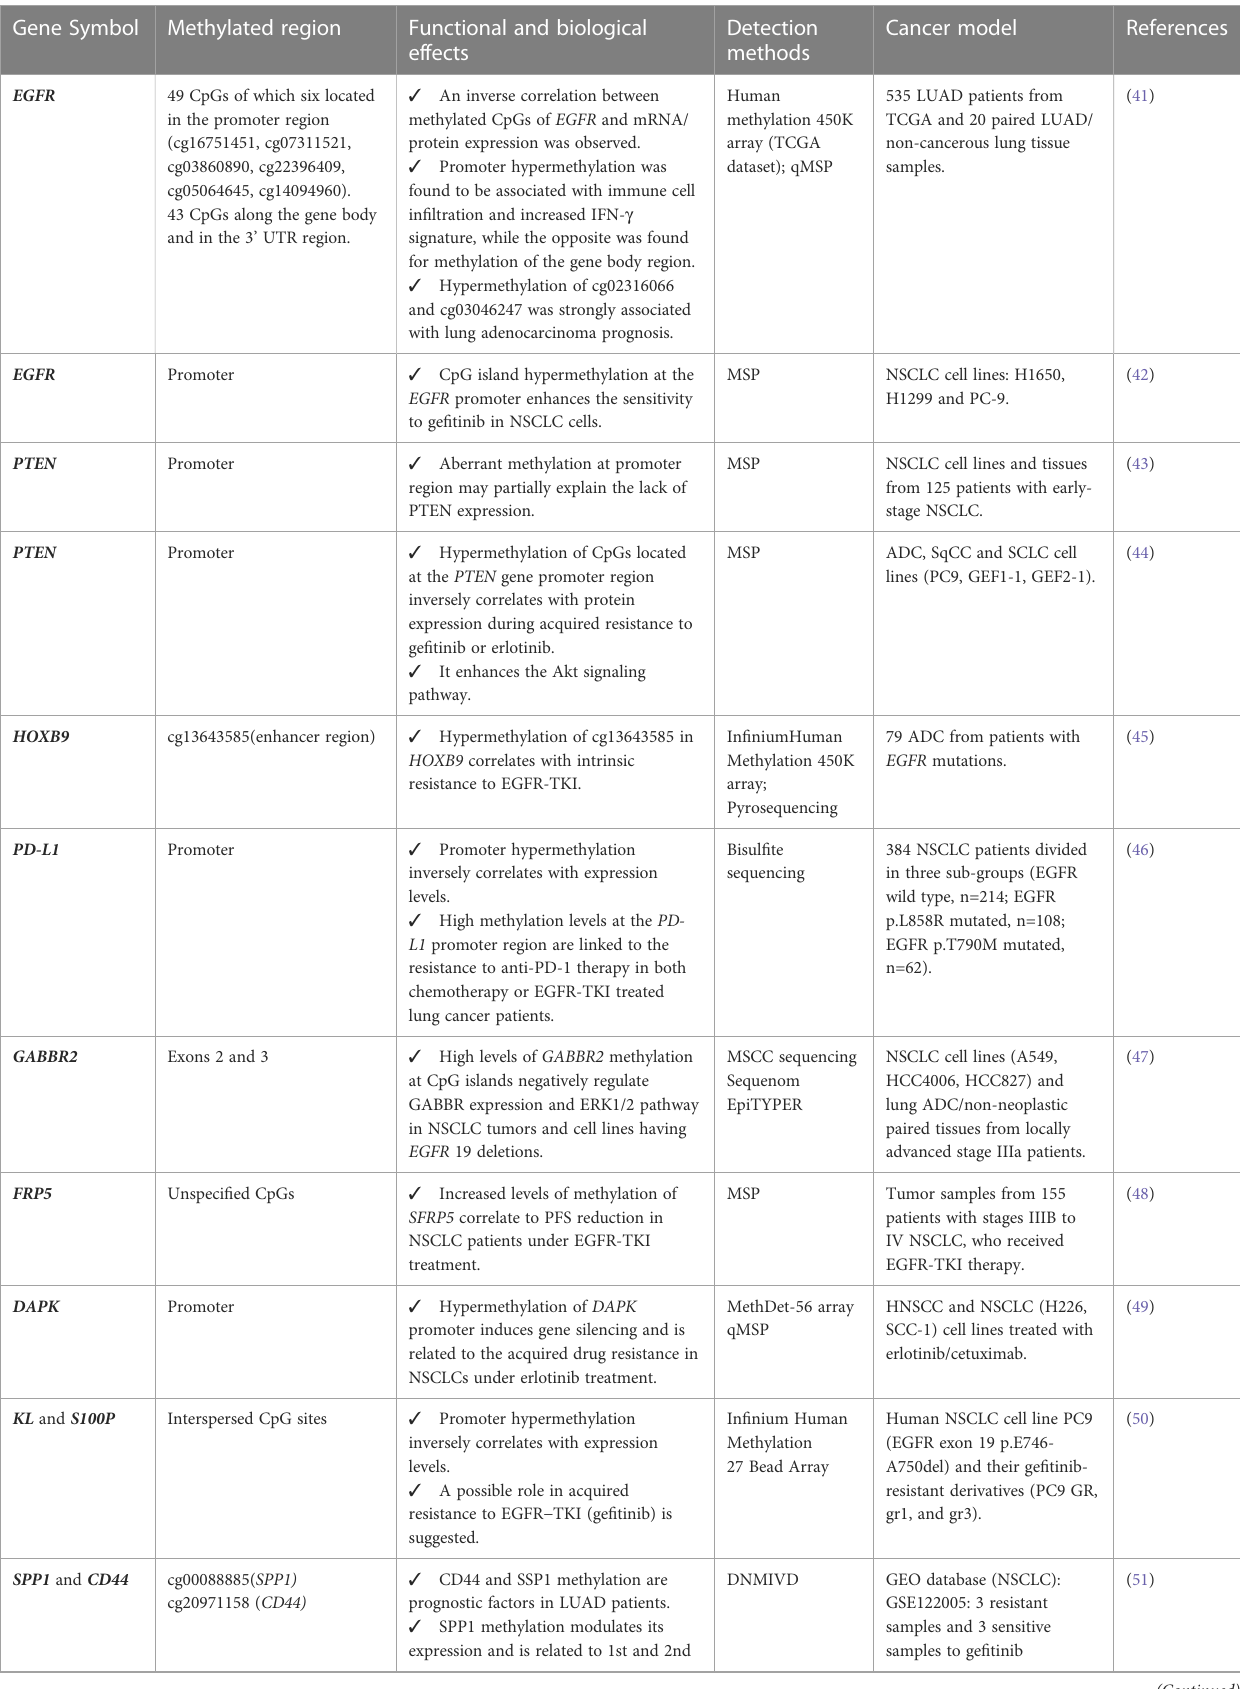
TABLE 1 Methylated genes and their functional and biological effects on acquired EGFR-TKI resistance in different lung cancer models. Gene